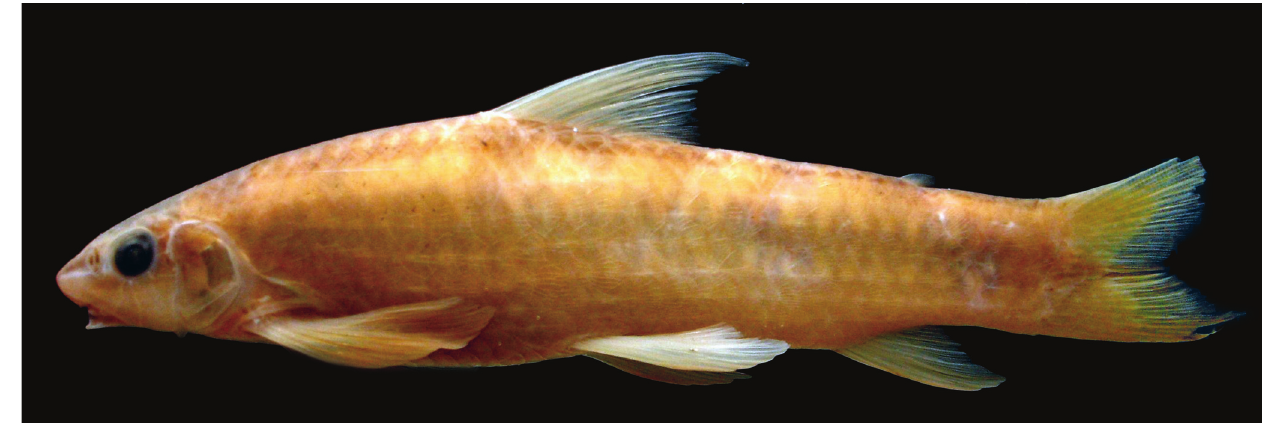
Fig. 11. Parodon suborbitalis , UF 21795, 104.6 mm SL, Venezuela, Lake Maracaibo basin, creek about 10 km N of Mene Grande, Zulia.